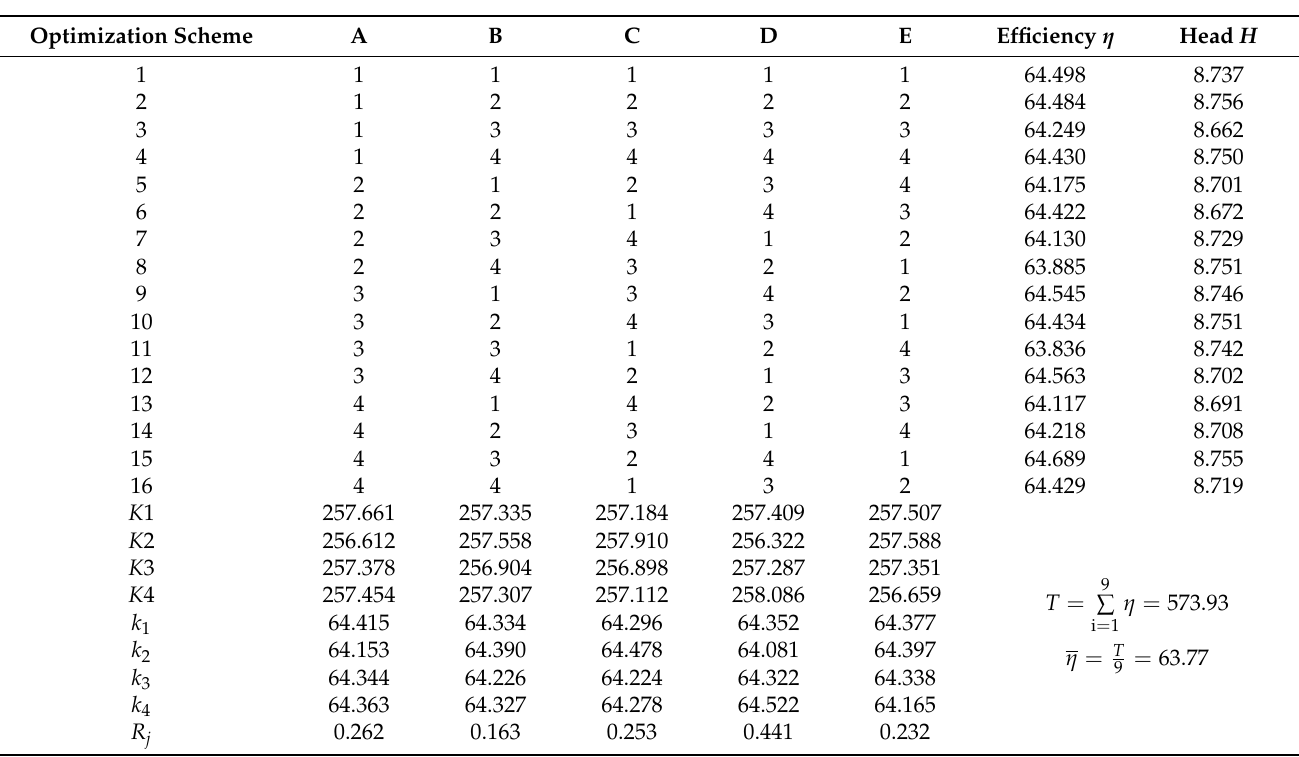
Table 4. Table of orthogonal optimization